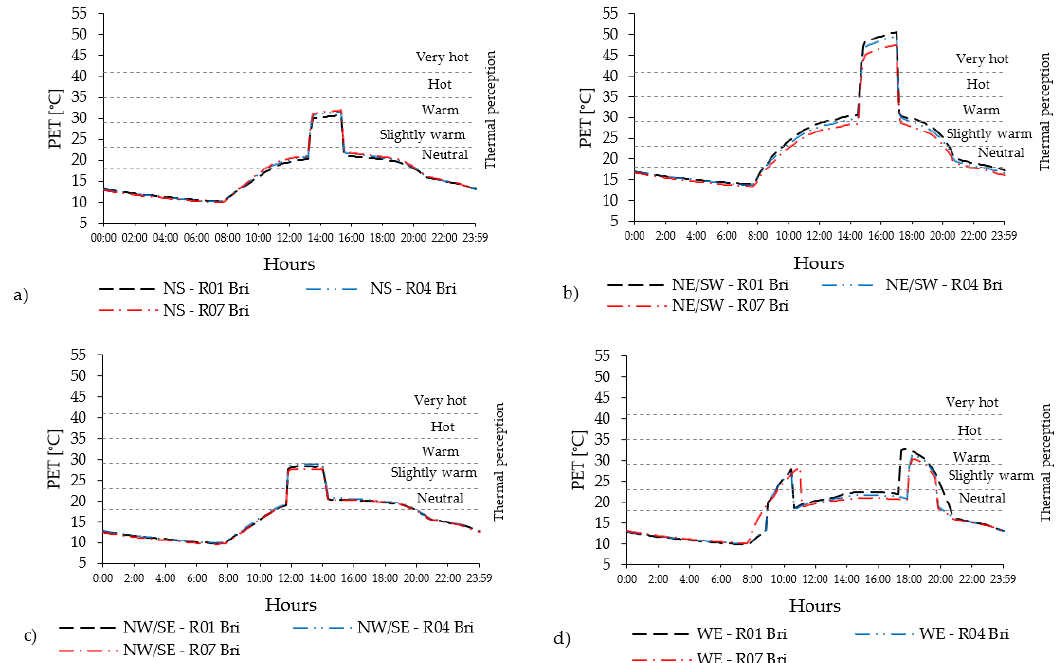
Figure 9. Spatial differences inside the UC of compact mid-rise urban and pavement in red brick stones: hourly evolution of the PET for different orientations ( a ) NS, ( b ) NE/SW, ( c ) NW/SE and ( d ) WE for receptors located at the beginning (R01) in the middle (R04) and at the end